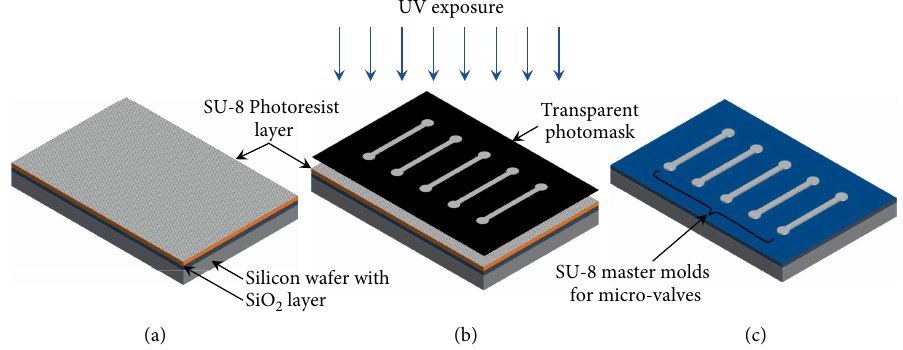
Figure 2: Fabrication of the SU-8 mold for valve channels. (a) Prepare a SU-8 photoresist layer on a 2-inch silicon wafer; (b) UV-exposure with a transparent mask; (c) a SU-8 master mold obtained after the final